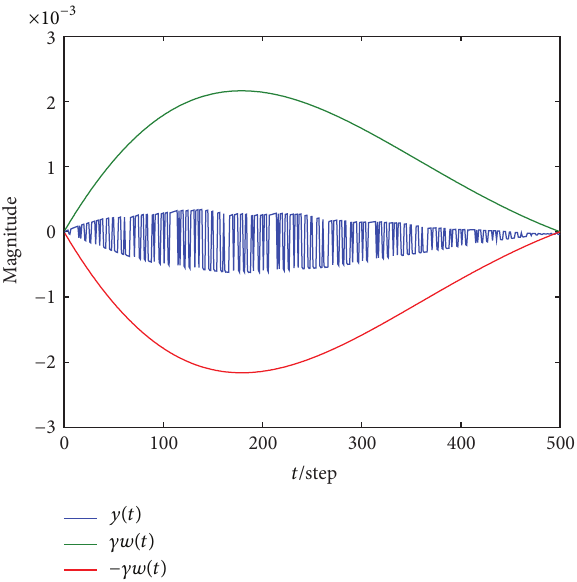
Figure 1: The states responses corresponding to uncertain parame- ters 𝜆 1 = 0.4 and 𝜆 2 = 0.6 .